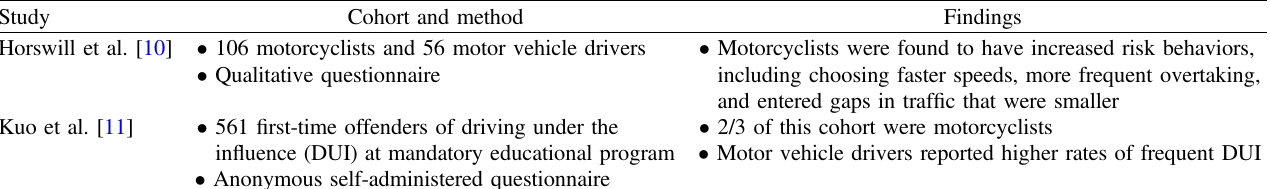
Table 1. Previous studies. Study Cohort and method